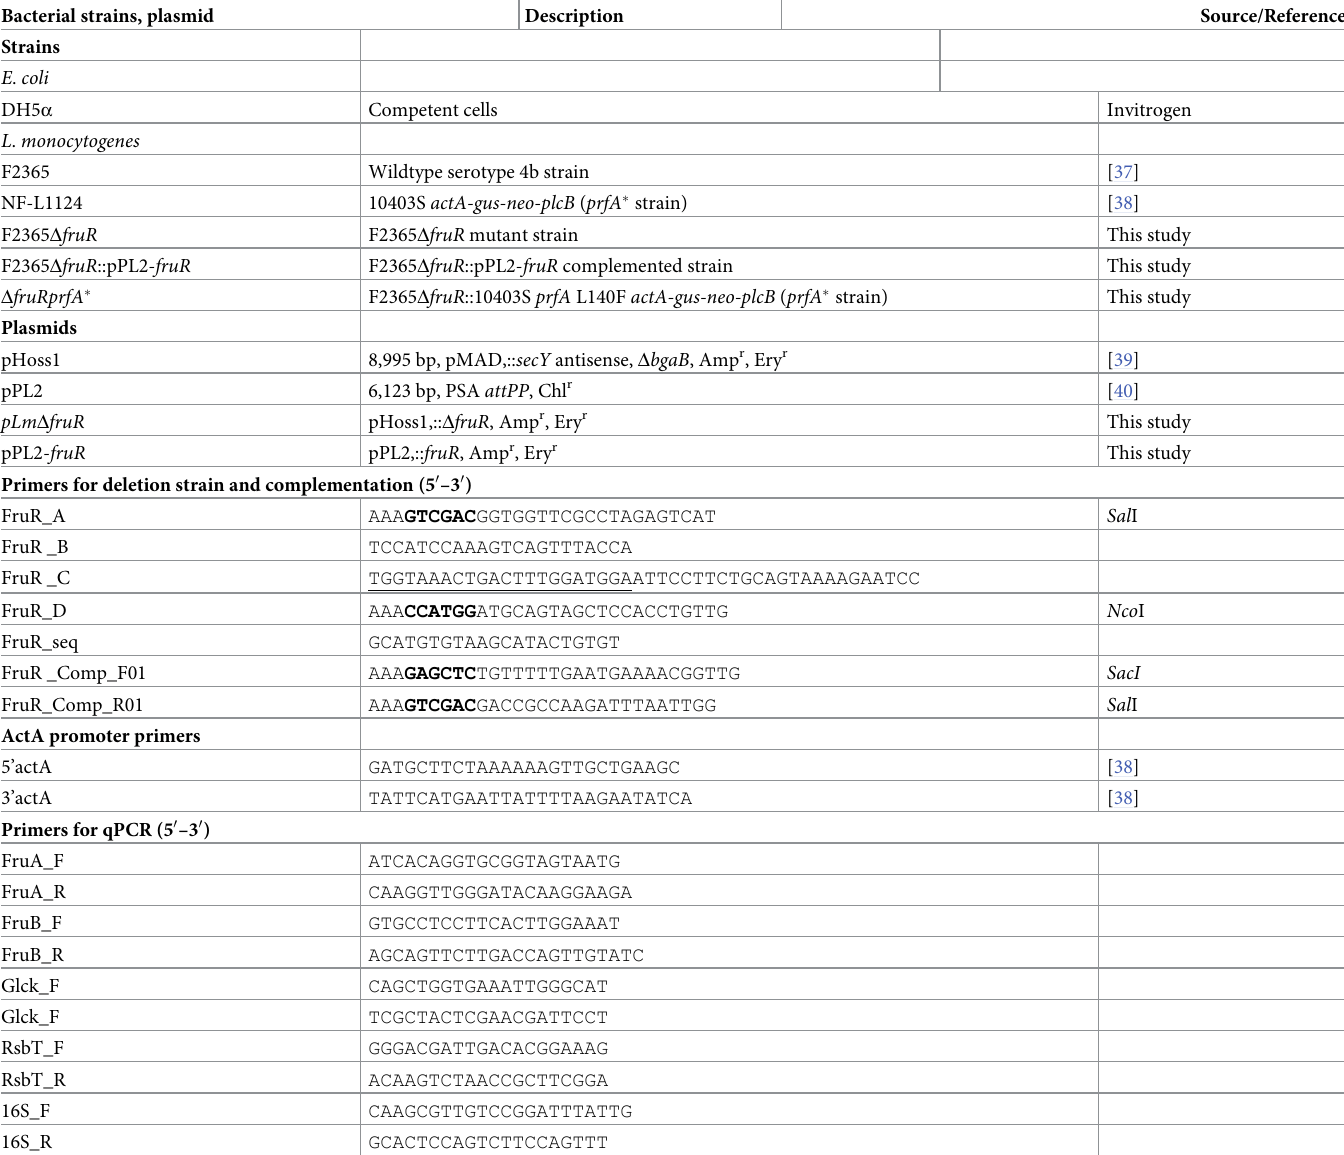
Table 1. Bacterial strains, plasmids, and primers used in this study. Bacterial strains, plasmid